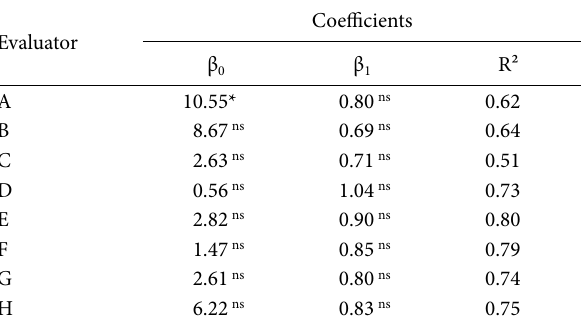
estimates of rust severity on fig leaves, for estimates performed by eight evaluators using the disease severity